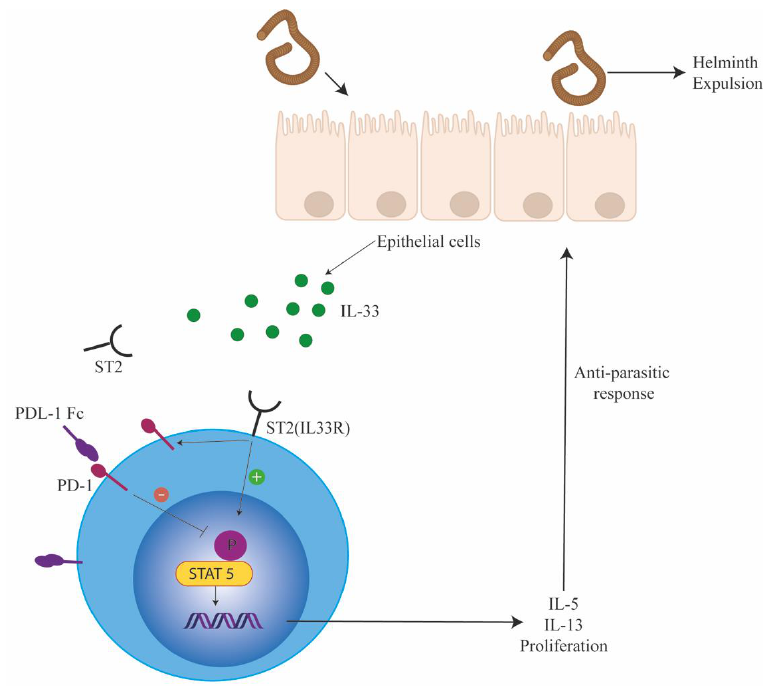
Figure 2. Innate lymphoid cells (ILC2s) are negatively regulated by PD-1. ILC2s are important for eliciting defense against parasitic infection. During parasitic infections, alarmins such as IL-33 are released by the gut epithelia cells. IL-33 activates ILC2s by binding to the IL-33R. On activation, ILC2s secrete type 2 cytokines that mediate Th2 responses, resulting in helminth expulsion. In addition, IL-33 also induces PD-1 receptor on ILC2s as a regulatory feedback loop (solid arrows). PD-1 dampens ILC2 proliferation and function on binding to its ligand PDL1 (inhibition shown by T